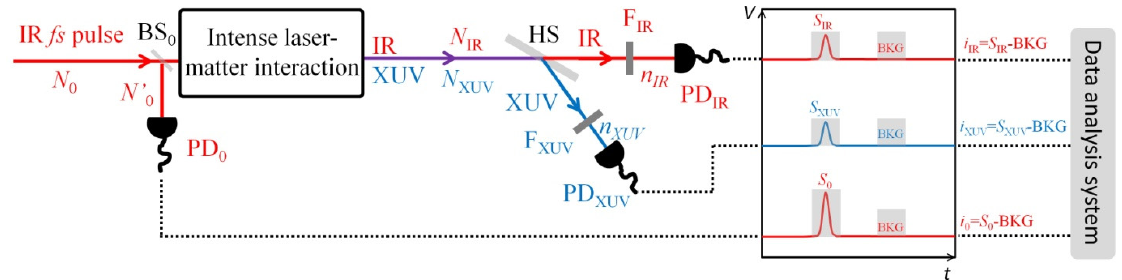
Figure 1. A schematic of the operation principle of a quantum spectrometer (QS). An intense fs infrared (IR) pulse with mean photon number N 0 is focused into the intense laser-matter interaction region where high harmonics are generated in the extreme-ultraviolet (XUV) spectral region. N IR (with N IR < N 0 ) and N XUV are the photon numbers of the IR and XUV fields exiting the high-order harmonic generation (HHG) medium. HS: harmonic separation optical element used to separate the XUV and IR beam. The generated harmonics can be spectrally resolved by steering the harmonic beam towards a conventional XUV spectrometer (not shown here). PD 0 : an IR photodiode used for measuring the shot-to-shot energy fluctuations of the IR driving pulse. BS 0 : IR beam separator, used to reflect a small portion of the IR beam, with photon number N’ 0 , to the PD 0 . PD IR : An IR photodiode. PD XUV : an XUV photodetector. n IR and n XUV are the IR and XUV photon number reaching the PD IR and PD XUV , respectively. F IR : IR neutral density filter used to attenuate the IR beam and avoid saturation effects on PD IR . F XUV : XUV thin metal filter used to select part of the HHG spectrum and eliminate any residual part of the IR beam. The V( t ) graph illustrates the voltage signals of the PD IR , PD XUV and PD 0 . The gray shaded areas in this graph depicts the gates used by a boxcar integrator to record for each shot the photocurrents S IR , S XUV , S 0 of the PD IR , PD XUV , PD 0 and the corresponding background electronic noise (BKG). After the BKG subtraction photocurrents i IR , i XUV , i 0 are recorded and analyzed.